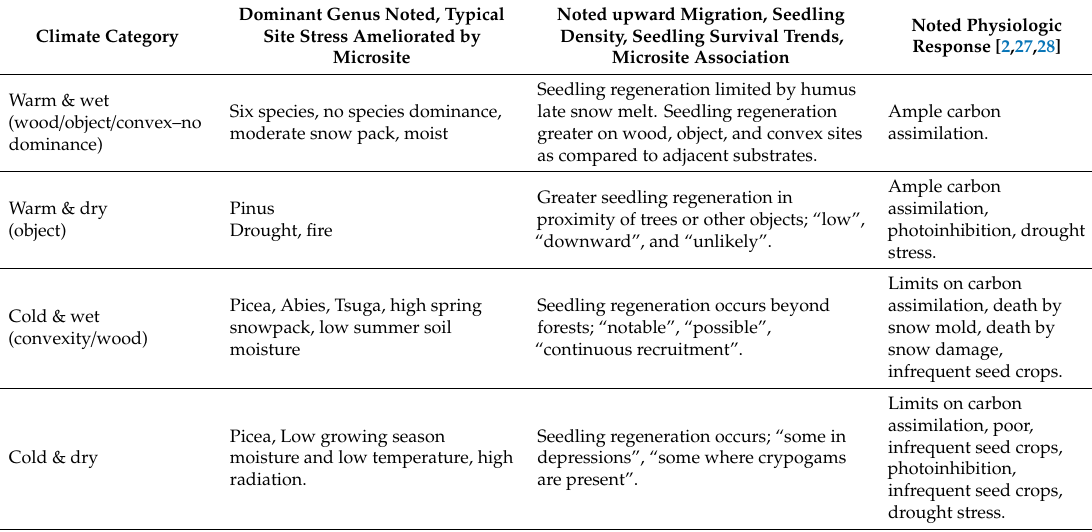
Table 2. Summary of microsite type, associated climate zone, and noted site